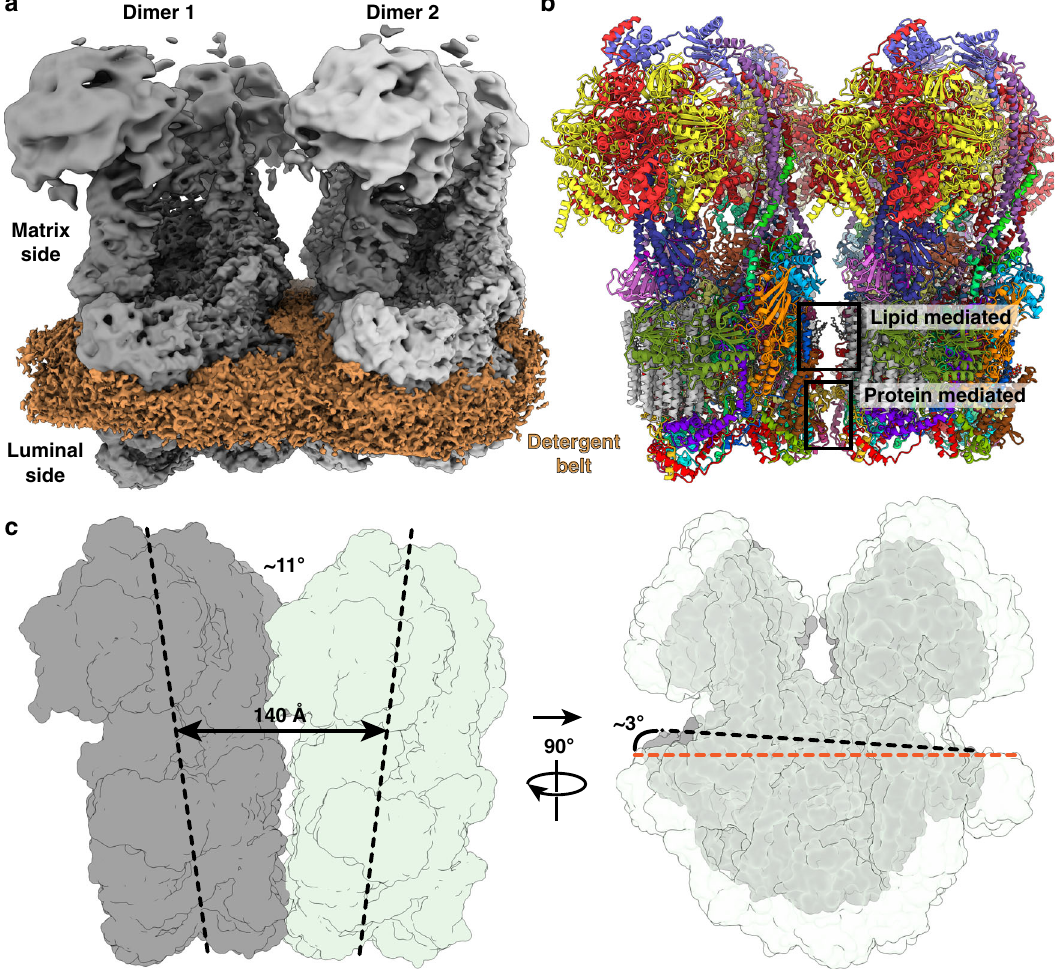
Fig. 6 Structure of type III ATP synthase tetramer. a Local-resolution fi ltered cryo-EM density map of ATP synthase F o tetramer. Dimer 1 is colored grey and dimer 2 colored light gray. b Model of ATP synthase tetramer. Boxes indicate protein and lipid interaction interfaces. c ATP synthase dimers spaced by 140 Å within tetramers are angled by ~11° (sideview, left) and ~3° (end-view, right), generating membrane